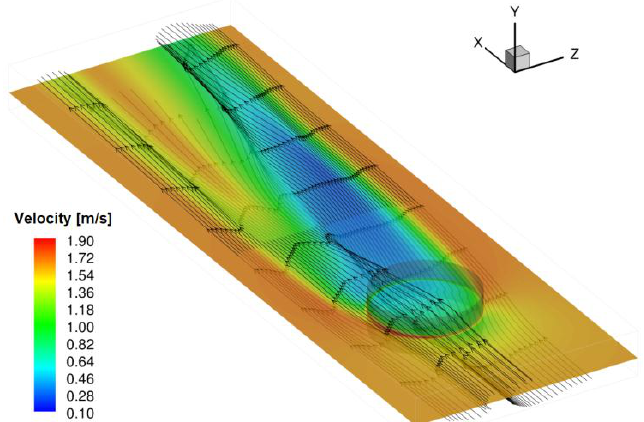
Figure 17. 3D isometric view of the averaged flow though the porous cylinder delimitated by the Σ surface (in gray transparency). Velocity field is shown at the plane y / H = 0.5 together with some streamlines to illustrate the complexity of the averaged flow across the turbine.